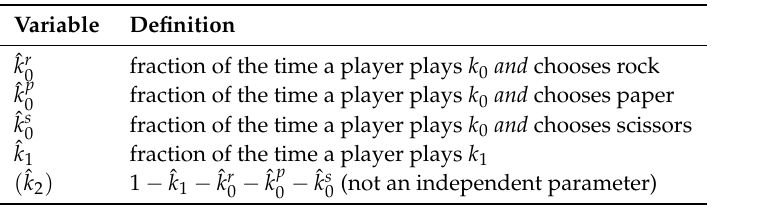
Table 6. Parameters of the Structural